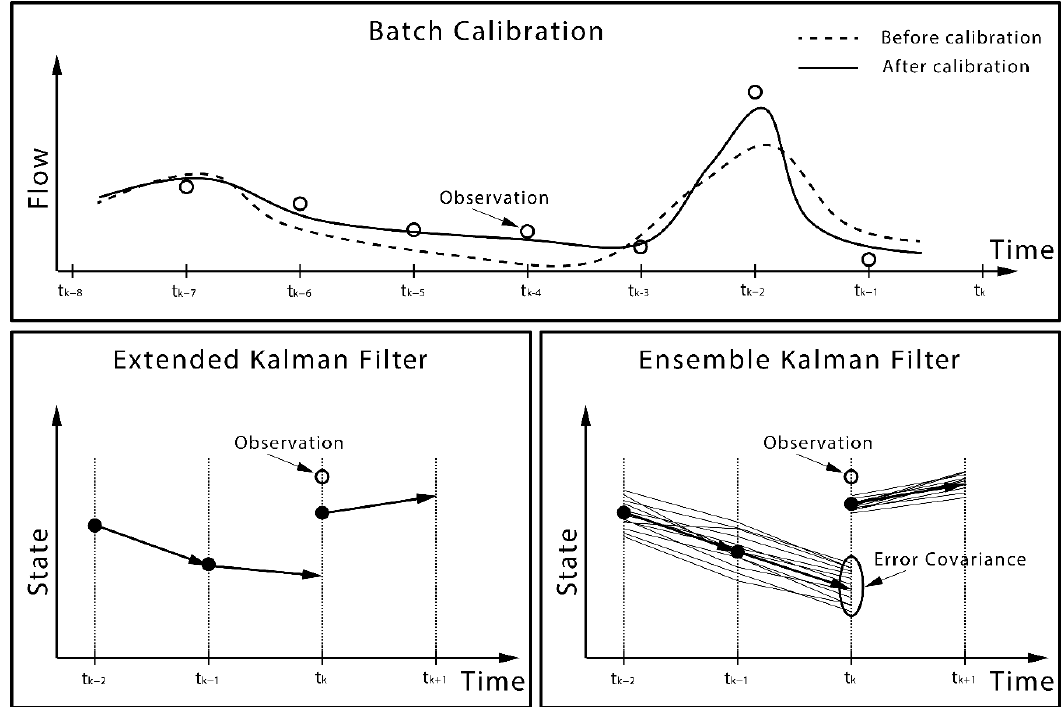
Figure 2. Schematic of exemplary approaches for data-model integration. t k represents the current time step.